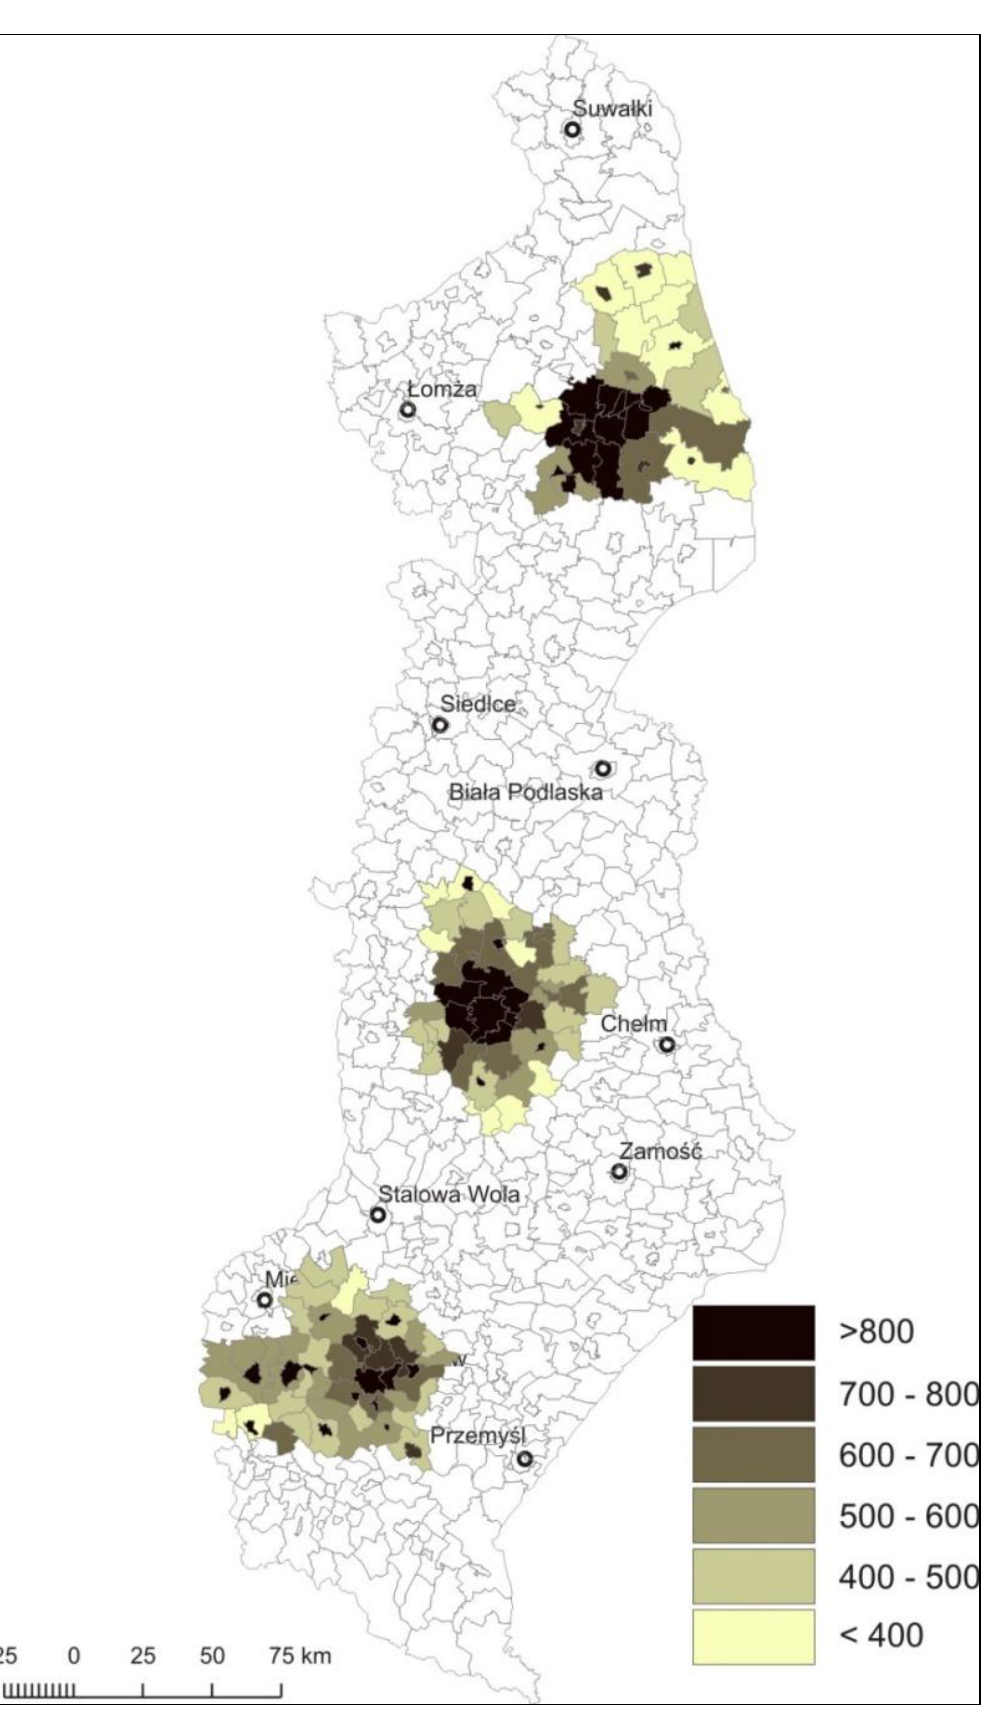
Fig. 7. Entities entered into the business registry REGON per 10 thousand inhabitants (2014) (author’s own elaboration based on data of the Local Data Bank of the Central Statistical